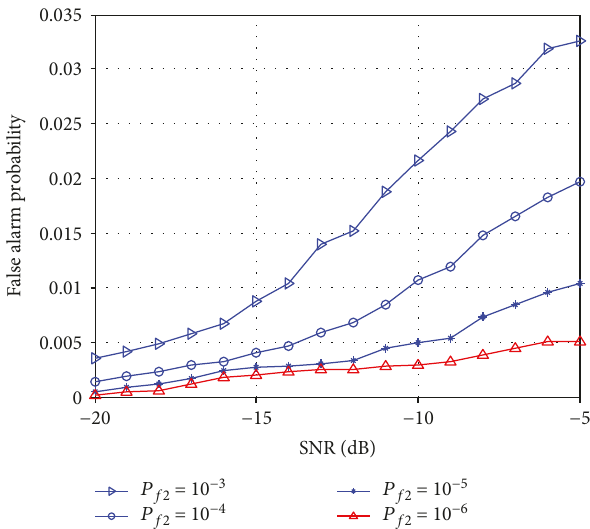
Figure 11: Probability of false alarm detection (signal